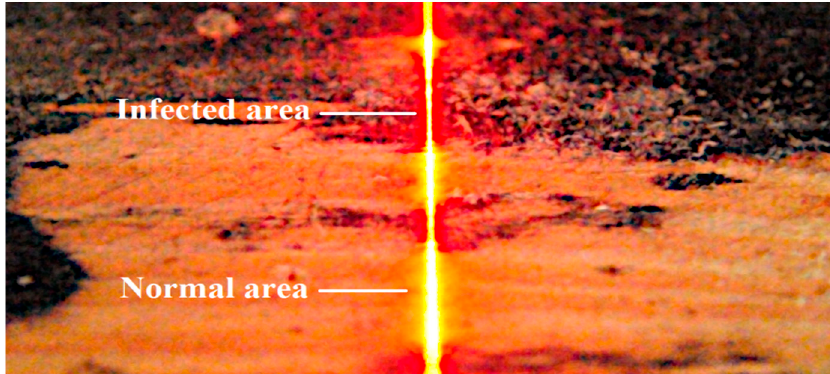
Figure 7. Laser line scattering on the surface of the board with healthy and infected